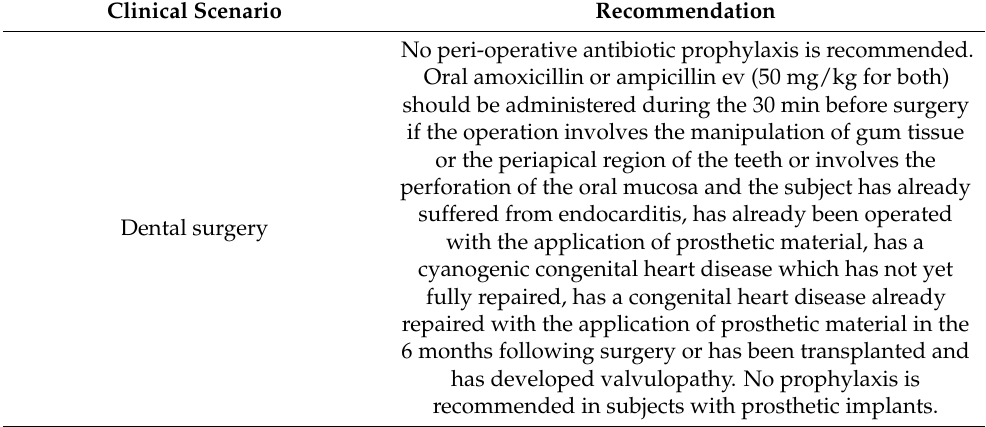
Table 2. Surgical antimicrobial prophylaxis (SAP) for neonates and children undergoing dental, maxillo-facial or ear-nose-throat (ENT)